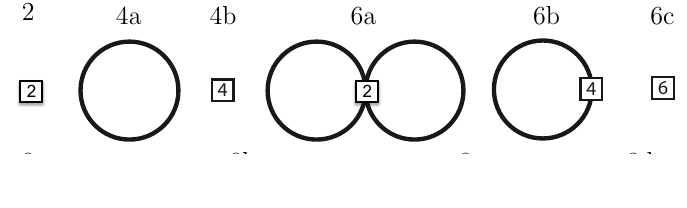
Figure 2 . Diagrams contributing to the energy density up to O ( p 6